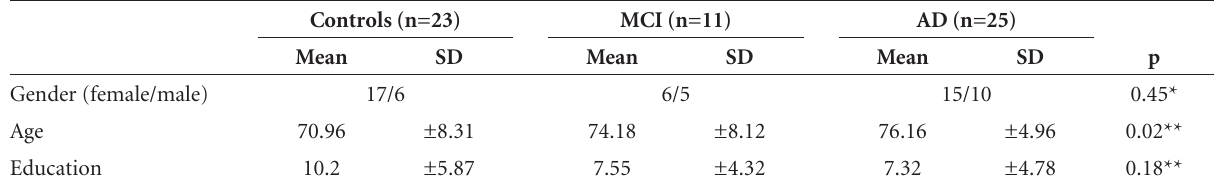
Table 1. Demographic characteristics of control, MCI, and AD